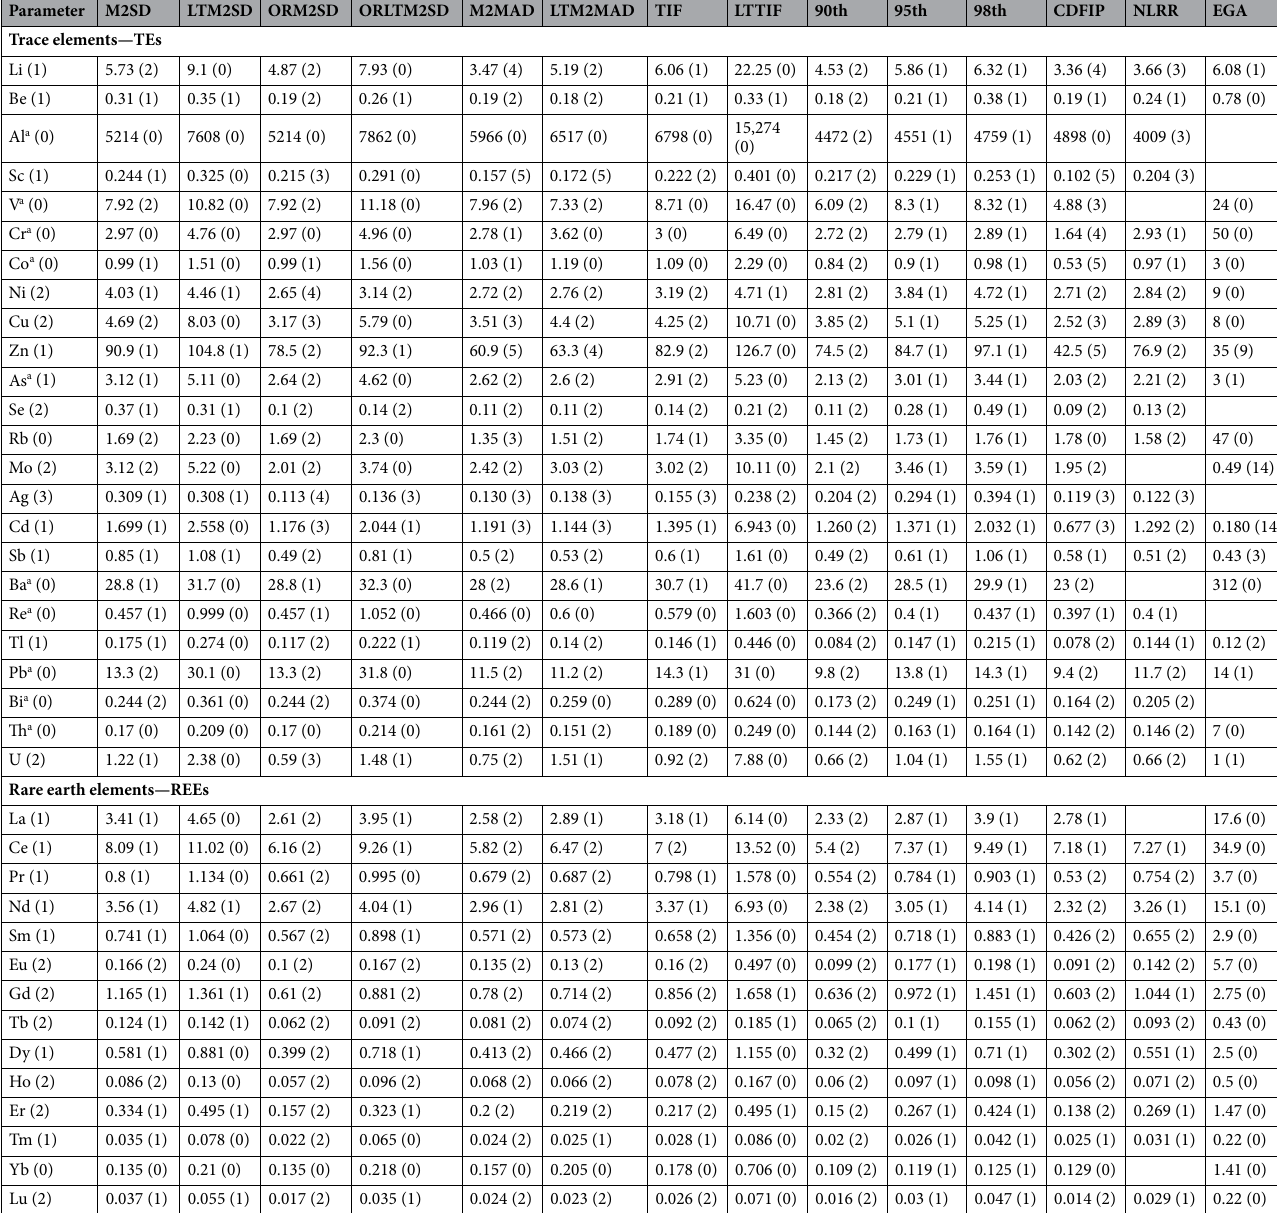
Table 4. GBV calculated by different methods. a Normal